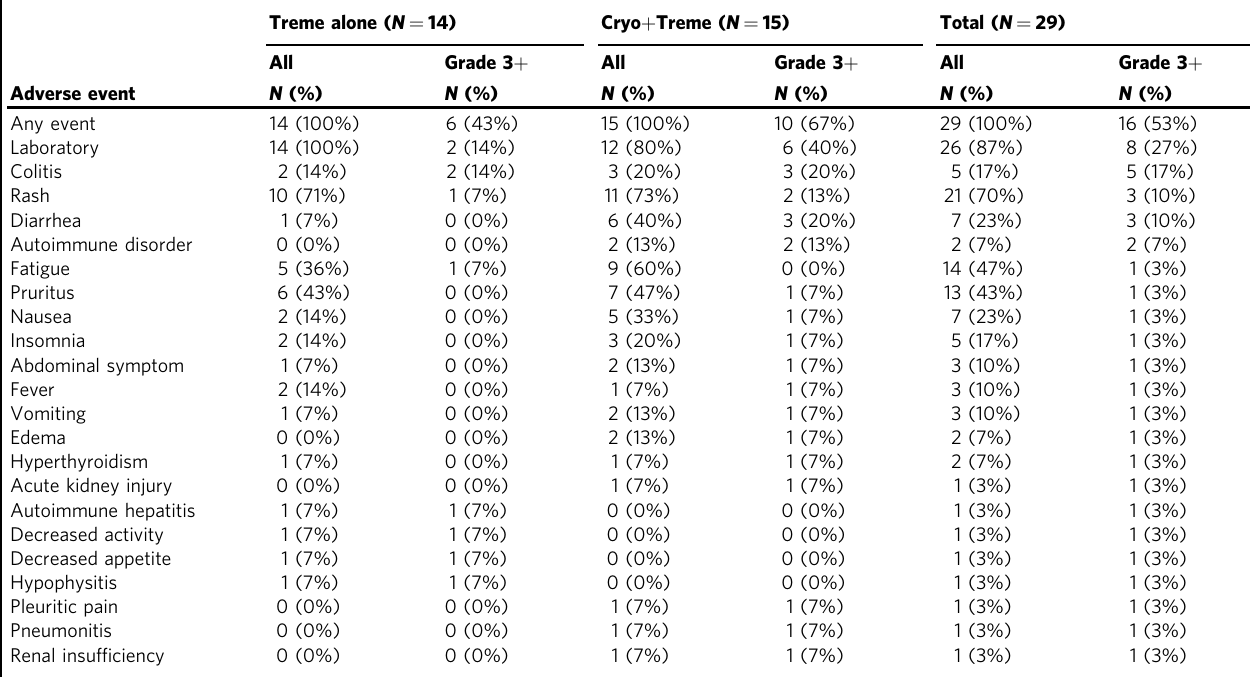
Table 2 Treatment-related grade 3 or higher